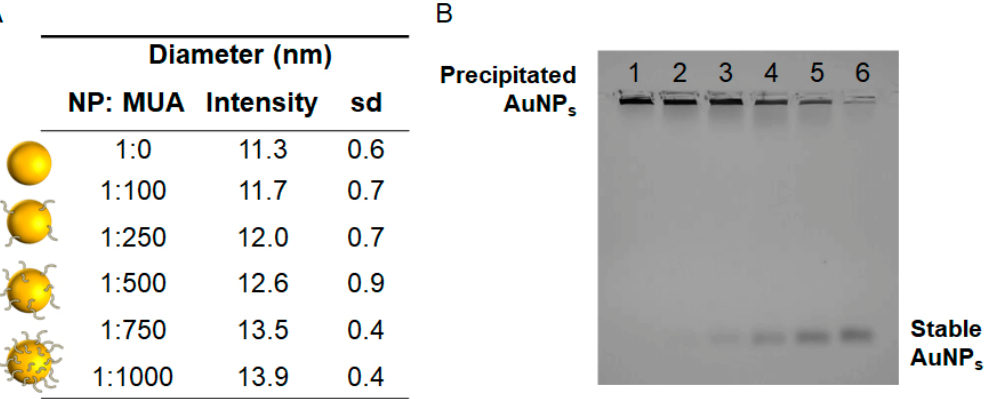
Figure 3. AuNPs surface modification with different concentrations of MUA. ( A ) AuNPs hydrody- namic size measured by Zetasizer in water. The diameter (intensity) increases linearly with MUA concentration on the surface. ( B ) Gel electrophoresis mobility shift of NP–citrate modified with MUA: Lanes: (1) NP–citrate, (2) 1:100 NP:MUA ratio, (3) 1:250 NP:MUA ratio, (4) 1:500 NP:MUA ratio, (5) 1:750 NP:MUA ratio, and (6) 1:1000 NP:MUA ratio.